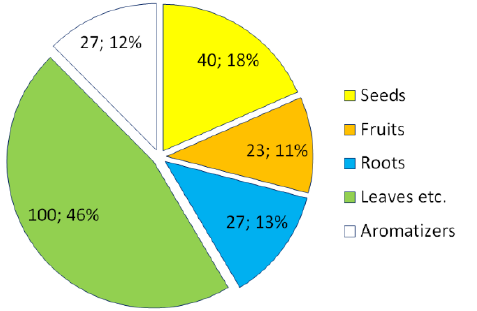
Figure 3. Frequency of citation of the 198 species in the sections of the work of Giovani Targioni Tozzetti [6].